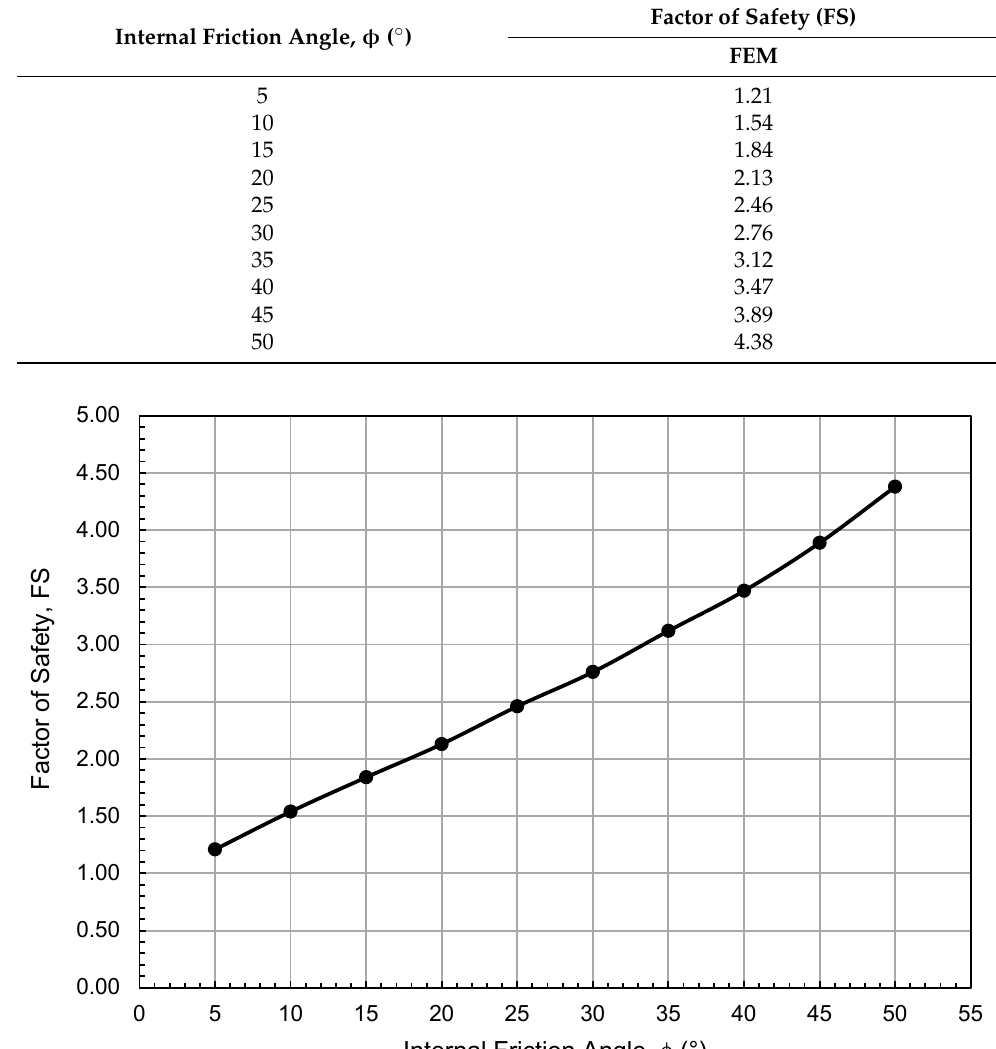
Table 11. Analysis results for different internal friction angle values (N = 4).